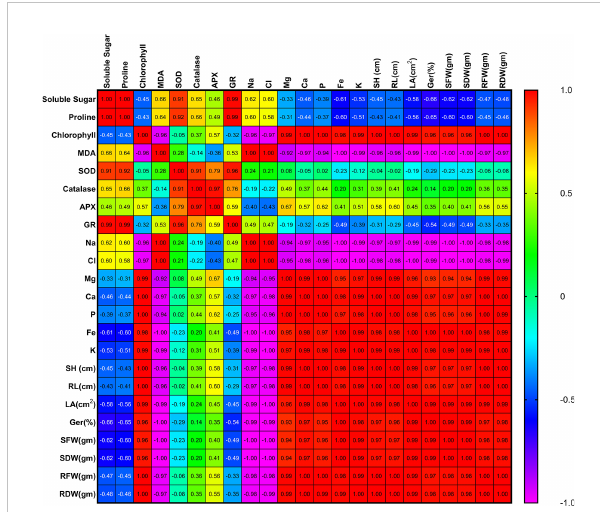
FIGURE 5 Correlation matrix among the different parameters of tomato plant in fl uenced by salt stress as well as PGPR inoculation. Here, MDA, Malondialdehyde; SOD, Superoxide dismutase; APX, Ascorbate peroxidase; GR, Glutathione reductase; Na, Sodium; Cl, Chloride; Mg, Magnesium; Ca, Calcium; P, Phosphorus; Fe, Iron; K, Potassium; SH, Shoot height; RL, Root length; LA, Leaf area; Ger(%), Germination (%); SFW, Shoot fresh weight; SDW, Shoot dry weight; RFW, Root fresh weight; RDW, Root dry weight.